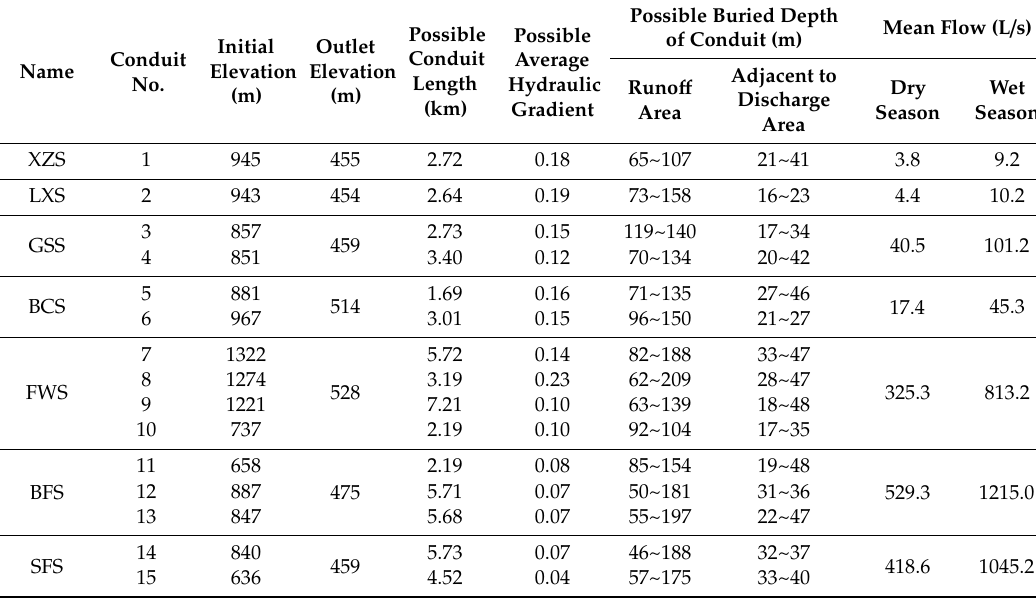
Table 3. Details of karst